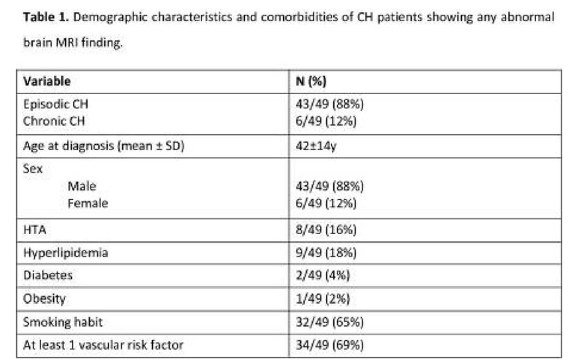
Table 2 (abstract P0152). See text for